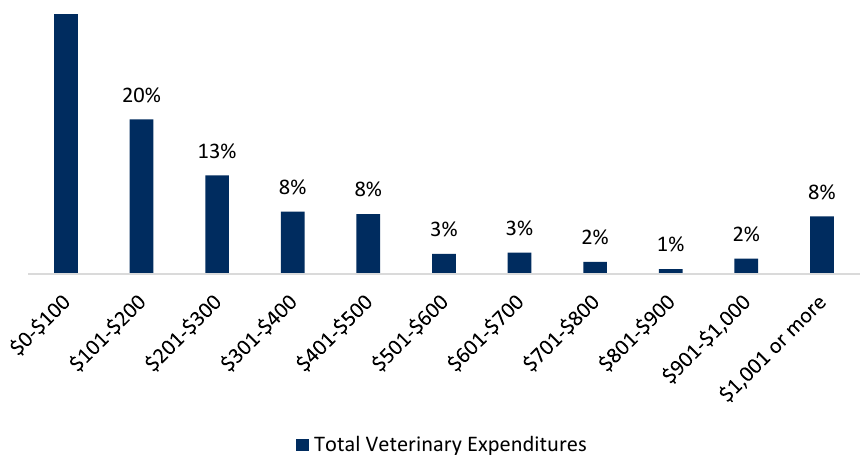
Figure 1. Total veterinary expenditures per pet owner per year.